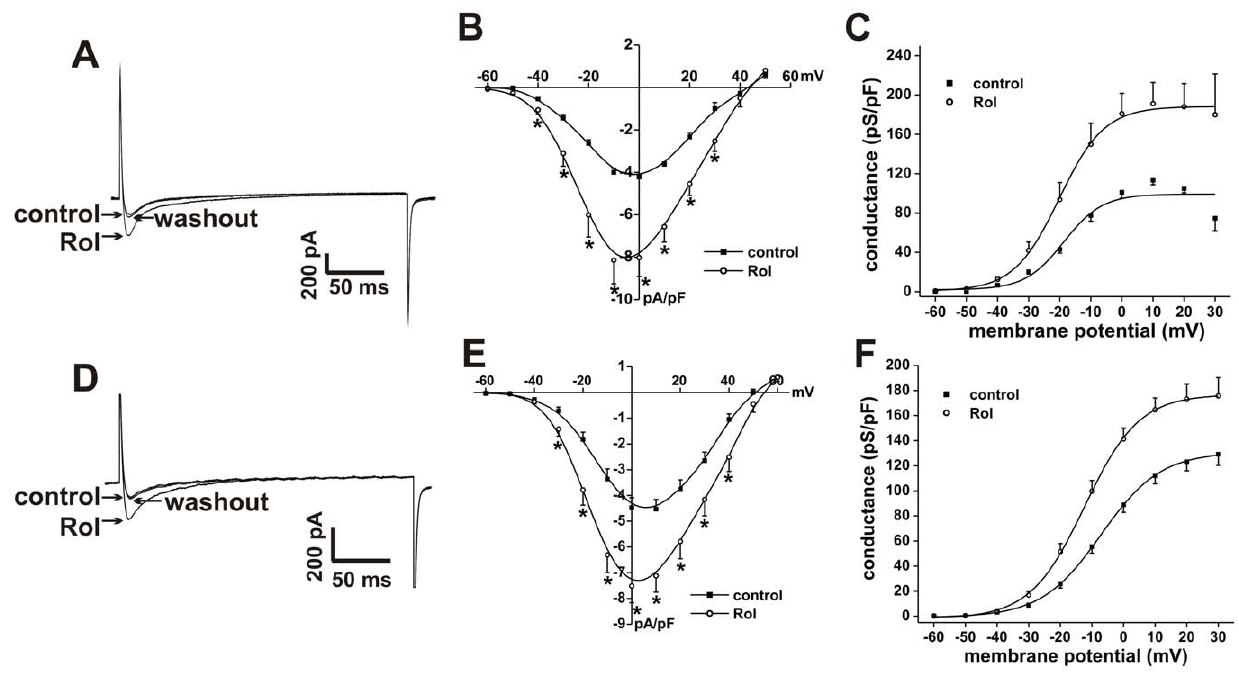
Figure 9. Effects of the PDE4 inhibitor rolipram on L-type Ca 2 + current in SAN and right atrial myocytes. A. Representative I Ca,L recordings in SAN myocytes in control conditions, in the presence of Rol (10 m M) and following Rol washout. B. Summary I–V relationships for the effects of Rol on SAN myocyte I Ca,L . C. Summary I Ca,L conductance density plots for the effects of Rol in SAN myocytes. D. Representative I Ca,L recordings in right atrial myocytes in control conditions, in the presence of Rol (10 m M), and following Rol washout. E. Summary I–V relationships for the effects of Rol on right atrial myocyte I Ca,L . F. Summary I Ca,L conductance density plots for the effects of Rol in right atrial myocytes. Summary data are means 6 SEM; n =6 SAN myocytes and 12 right atrial myocytes; * P , 0.05 vs. control by paired Student’s t